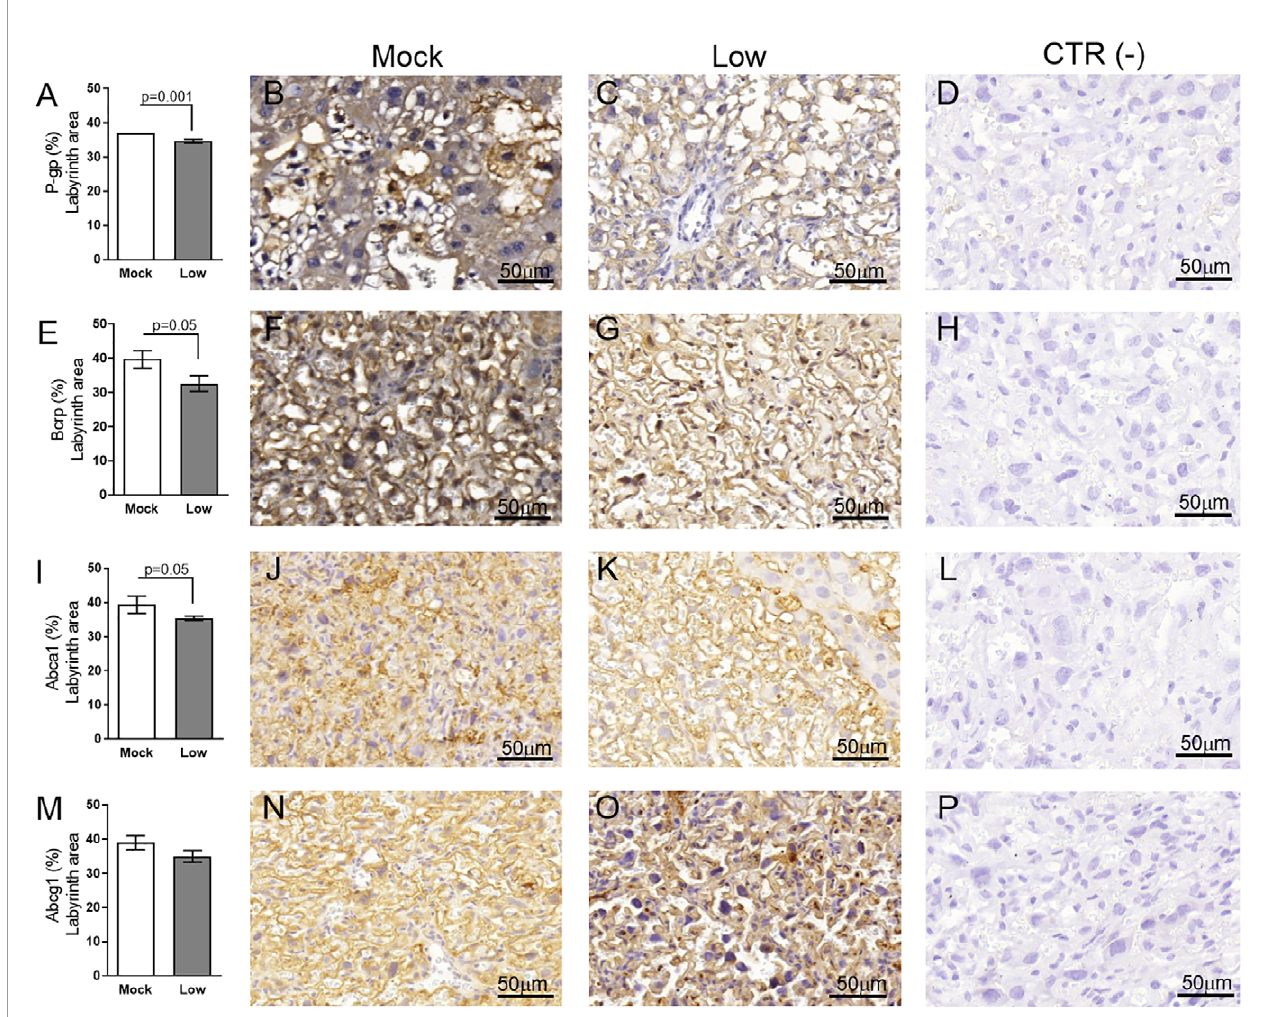
FIGURE 9 | ZIKV infection decreases P-gp, Bcrp and Abca1 protein expression in the placental Lz of infected mice in the ICompromised groups. A total of 180 digital images (40X) randomly captured from the whole labyrinth zone (Lz) of each placenta per dam were evaluated. Immunolabeling in each digital image was quanti fi ed by calculating the percentage area of the total stained labyrinth zone tissue after exclusion of the total negative space. (A) Quanti fi cation and (B, C) representative photomicrographs of P-gp staining in the Lz of ICompromised (n=3 placentae from 3 independent dams/group) placenta. (E) Quanti fi cation and (F, G) representative photomicrographs of Bcrp staining in the Lz of ICompromised (n=3 placentae from 3 independent dams/group) placenta. (I) Quanti fi cation and (J, K) representative photomicrographs of Abca1 staining in the Lz of ICompromised (n=3 placentae from 3 independent dams/group) placenta (M) quanti fi cation and (N, O) representative photomicrographs of Abcg1 staining in the Lz of ICompromised (n=3 placentae from 3 independent dams/group) placenta. (D, H, L, P) Negative controls. Unpaired Student ’ s t-test or nonparametric Mann-Whitney test was used to assess differences between ICompromised groups. The values are expressed as the mean ± SEM. Images were captured at 40X. Scale ba r= 50